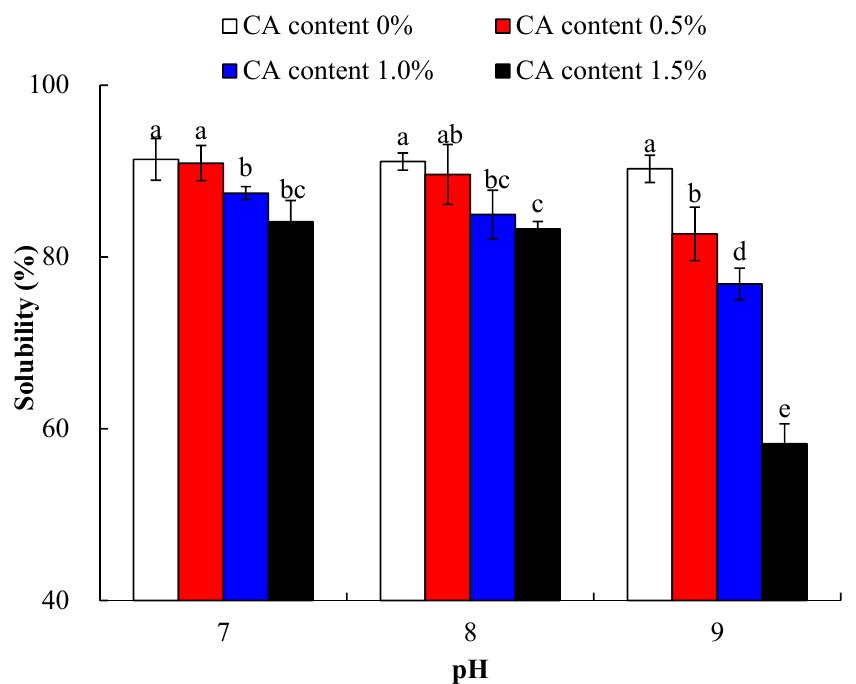
Figure 2. Zeta potential of WPI incubated with CA (0, 0.5, 1.0 and 1.5%) at pH 7.0, pH 8.0, or pH 9.0, and at 50 °C for 6 h. Error bars represent the standard deviation of the mean of triplicate experiments. Values with different letters are significantly different ( p < 0.05).